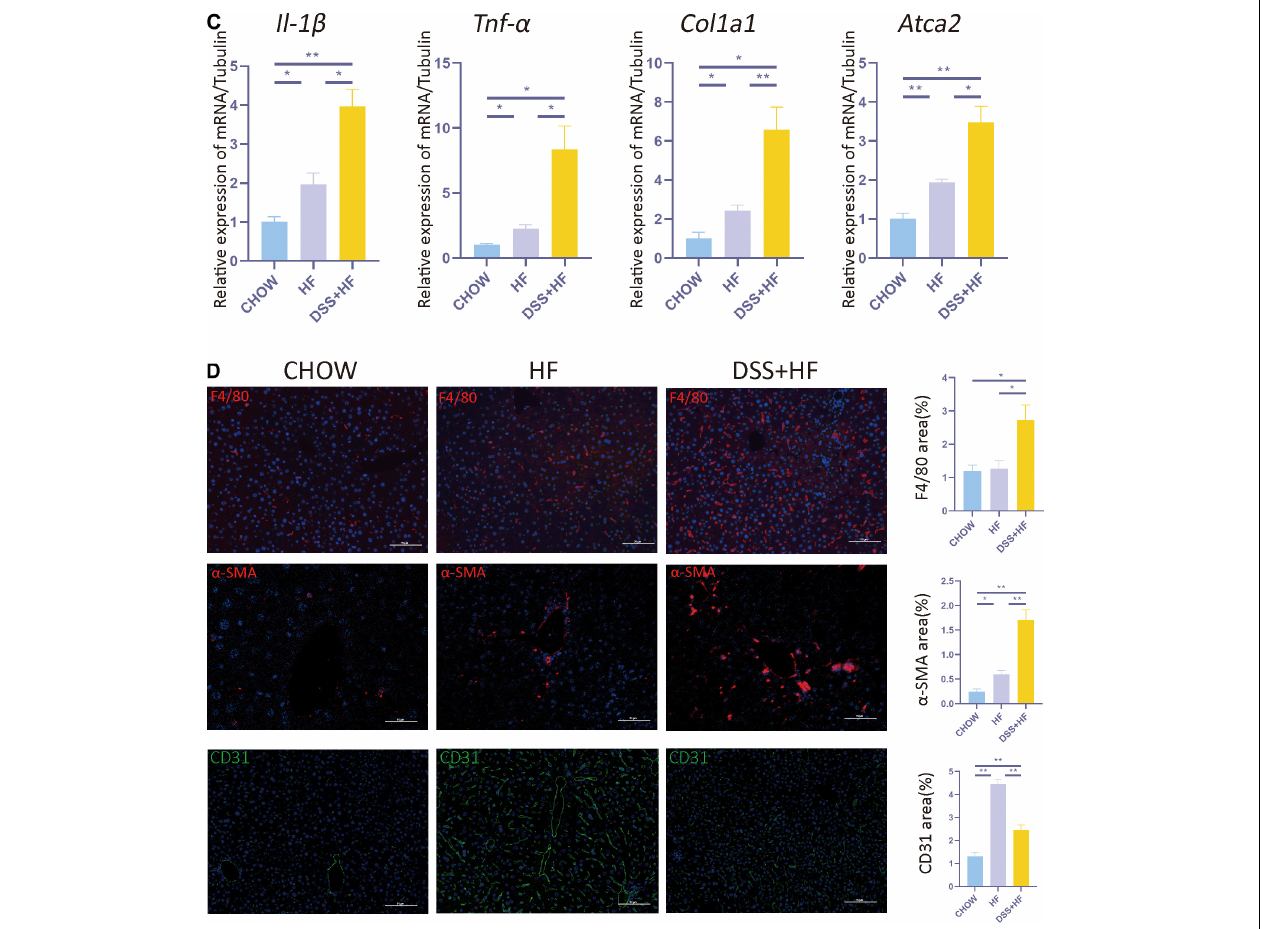
FIGURE 1 | Dextran sulfate sodium salt (DSS) treatment aggravates hepatic inflammation and fibrosis in mice with non-alcoholic steatohepatitis (NASH). (A) Experimental model: After 1 week of acclimatization, 27 C57BL/6J mice (male, 9 weeks old) were divided into three groups: (1) chow group ( n = 9), conventionally raised with distilled water and standard chow; (2) HF group (n = 9), raised with high-fructose diet and 60% high-fat diet; (3) DSS (+HF group (n = 9), raised with 1% DSS, high-fructose diet and 60% high-fat diet; DSS was applied in cycles and each cycle consisted of 7 days DSS administration followed by a 10-day inter-val with normal drinking water. The cycles were repeated throughout the experimental period of 18 weeks. (B) Represen-tative images for oil red, H&E and Sirius Red stained liver samples from chow, HF and DSS + HF group; The statistical analy-sis of the area of oil red, inflammation score and Sirius Red. The data are expressed as the mean ± SEM. *PP < 0.05; **PP < 0.01. (C) II-1 β , Tnf - α , Col1a1 , and ATCA2 expression at the mRNA level in liver samples from the above groups. (D) Representative immunofluorescence (IF) images of α -SMA, F4/80, and CD31 in liver samples from chow, HF and DSS + HF group; the statistical analysis of the staining area of α -SMA, F4/80, and CD31. The data are expressed as the mean ± SEM. * P < 0.05;** P < 0.01.